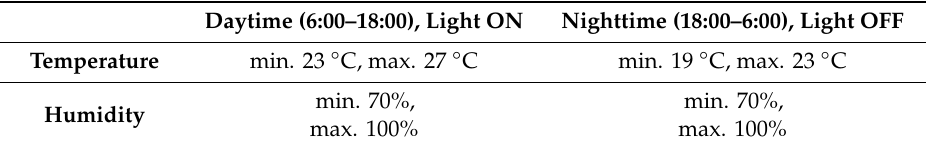
Table 1. Values set for the chamber test